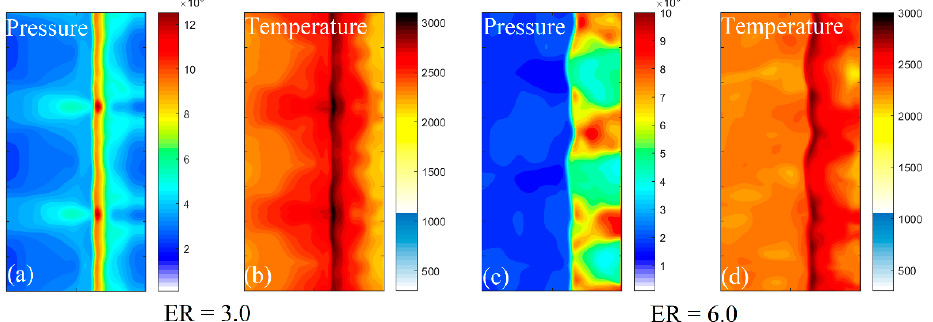
Figure 11. Pressure and temperature distributions at different equivalence ratios after detonation impacts the wall for 0.2 µs. ( a ) Pressure at ER = 3.0; ( b ) Temperature at ER = 3.0; ( c ) Pressure at ER = 6.0; ( d ) Temperature at ER = 6.0.